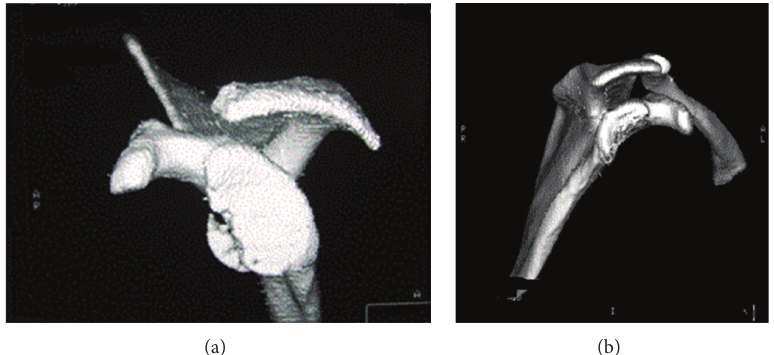
Figure 1: 3-dimensional CT scans demonstrating (a) fragmentary bone loss and (b) attritional bone loss of the glenoid.